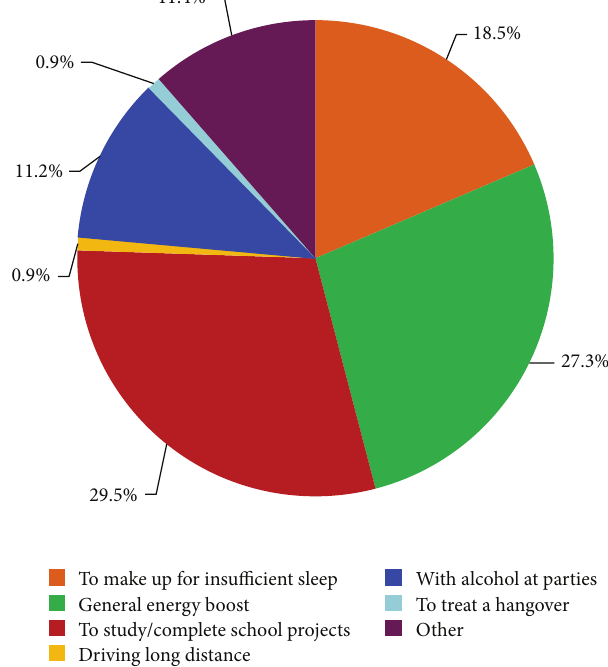
Figure 4: Motivations for consuming energy drinks.